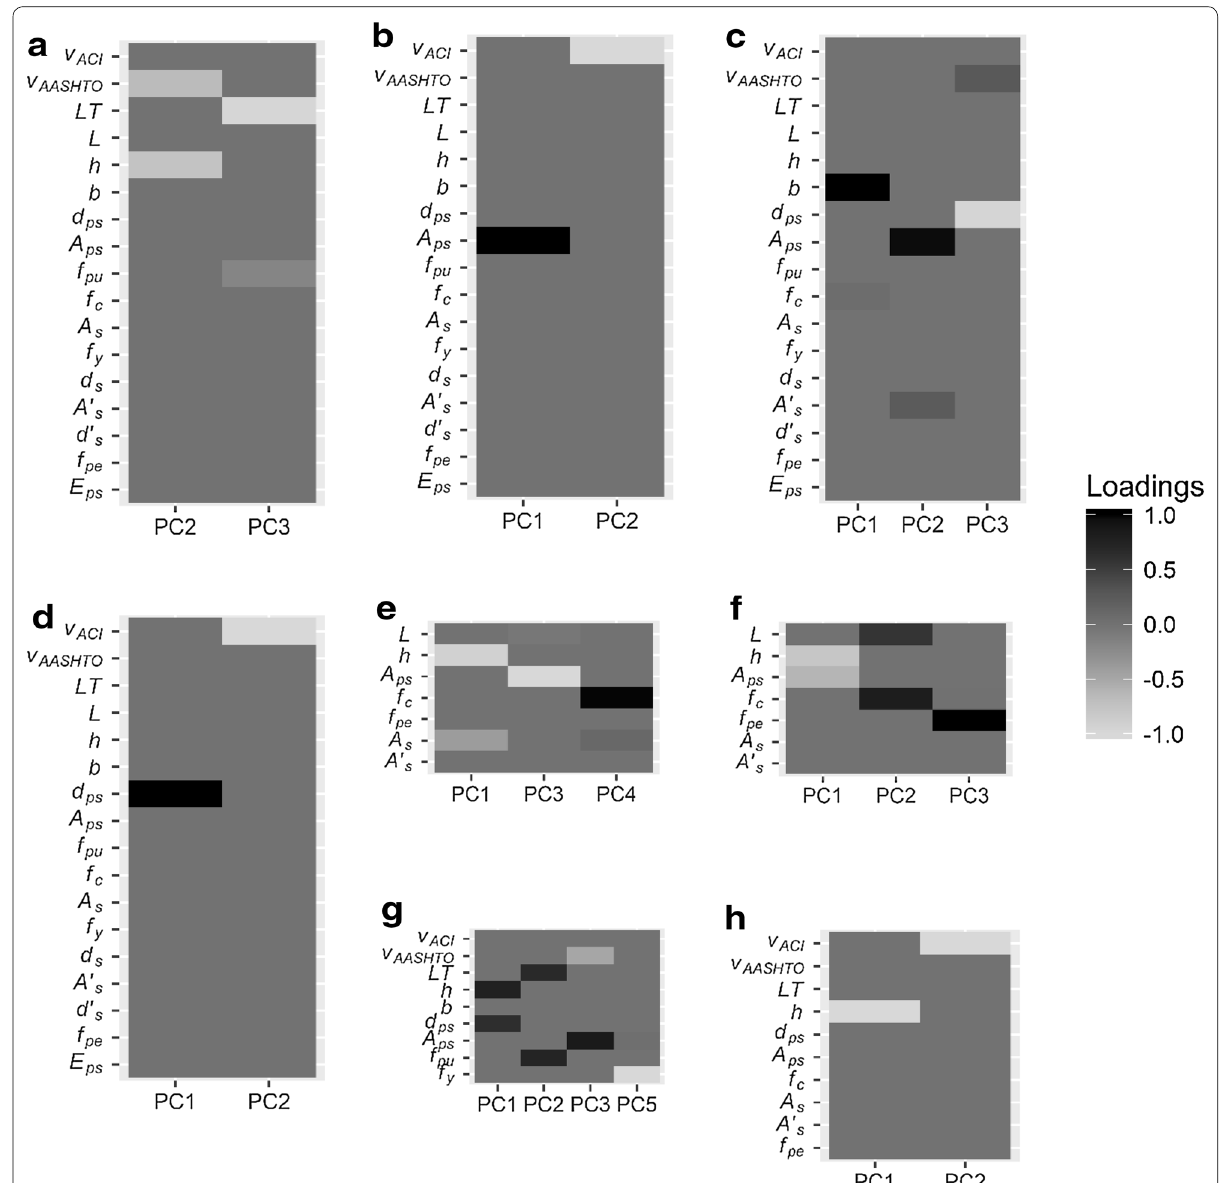
Fig. 4 SPCA loading heat maps for the a SPCA-All-Int, b SPCA-All-Ext, c SPCA-ContCate-Int, d SPCA-ContCate-Ext, e SPCA-SS-Int, f SPCA-SS-Ext, g SPCA-CC-Int, and h SPCA-CC-Ext